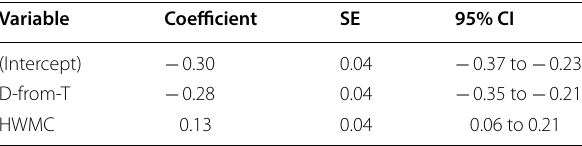
Table 4 Regression coefficients of the within-HW model (after model